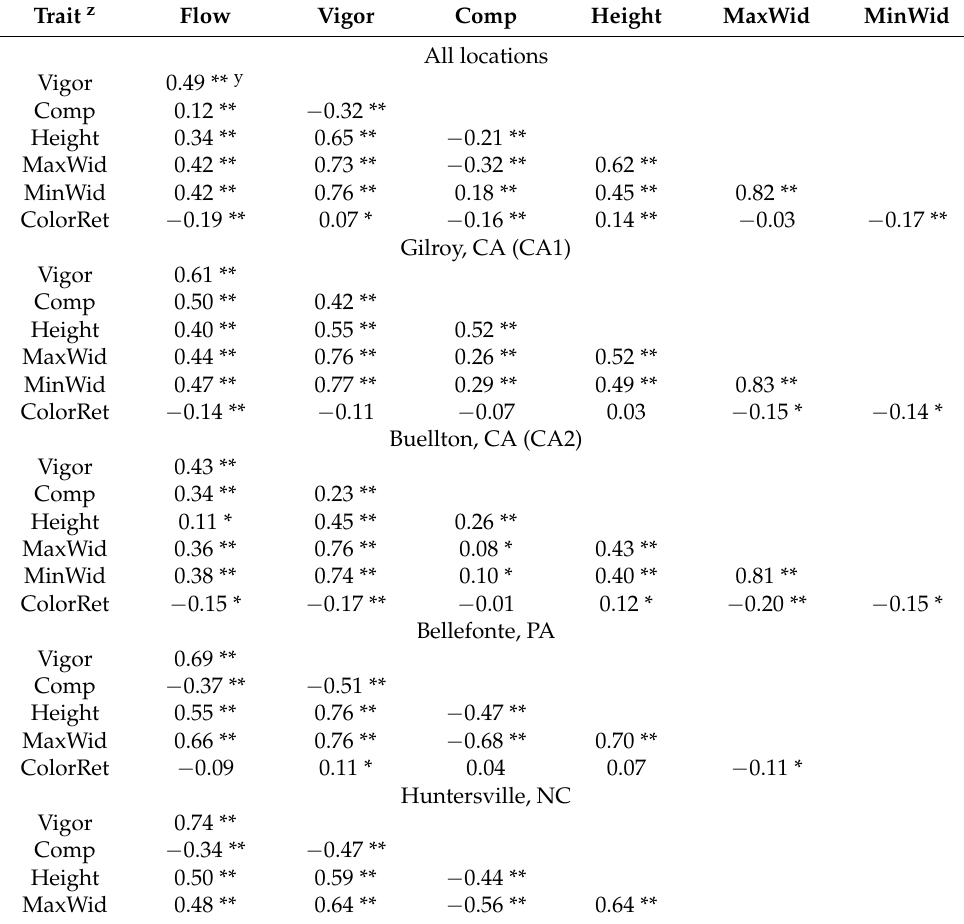
PE = Petunia exserta . x ns and * indicate non-significance or significance at p < 0.05, respectively. w na = trait was not measured for this parent. Flow was positively correlated with Vigor, Height, and MaxWid at all four locations (Table 3). Trait correlations were generally similar (in both direction and significance) across locations except for correlations between Comp and other traits. For example, Comp was correlated positively with Height and MaxWid at CA1 and CA2, but negatively at NC and PA. Table 3. Pearson’s correlation coefficients at different locations for field performance traits analyzed in P. axillaris × P. exserta F 7 recombinant inbred line population. Trait